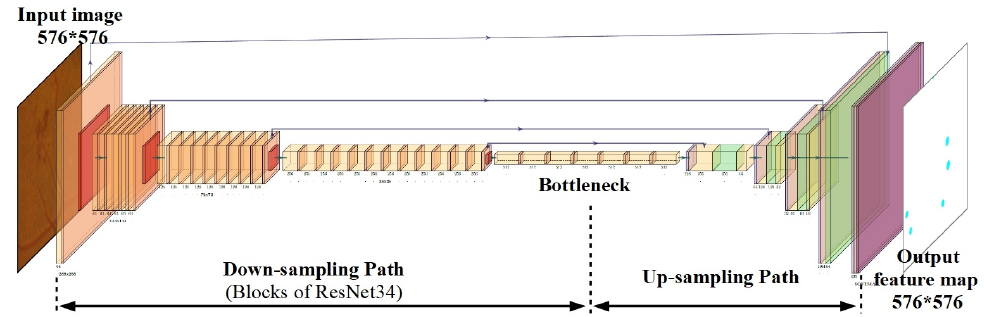
Figure 5. The deep neural network structure of the ResNet34-UNet model.